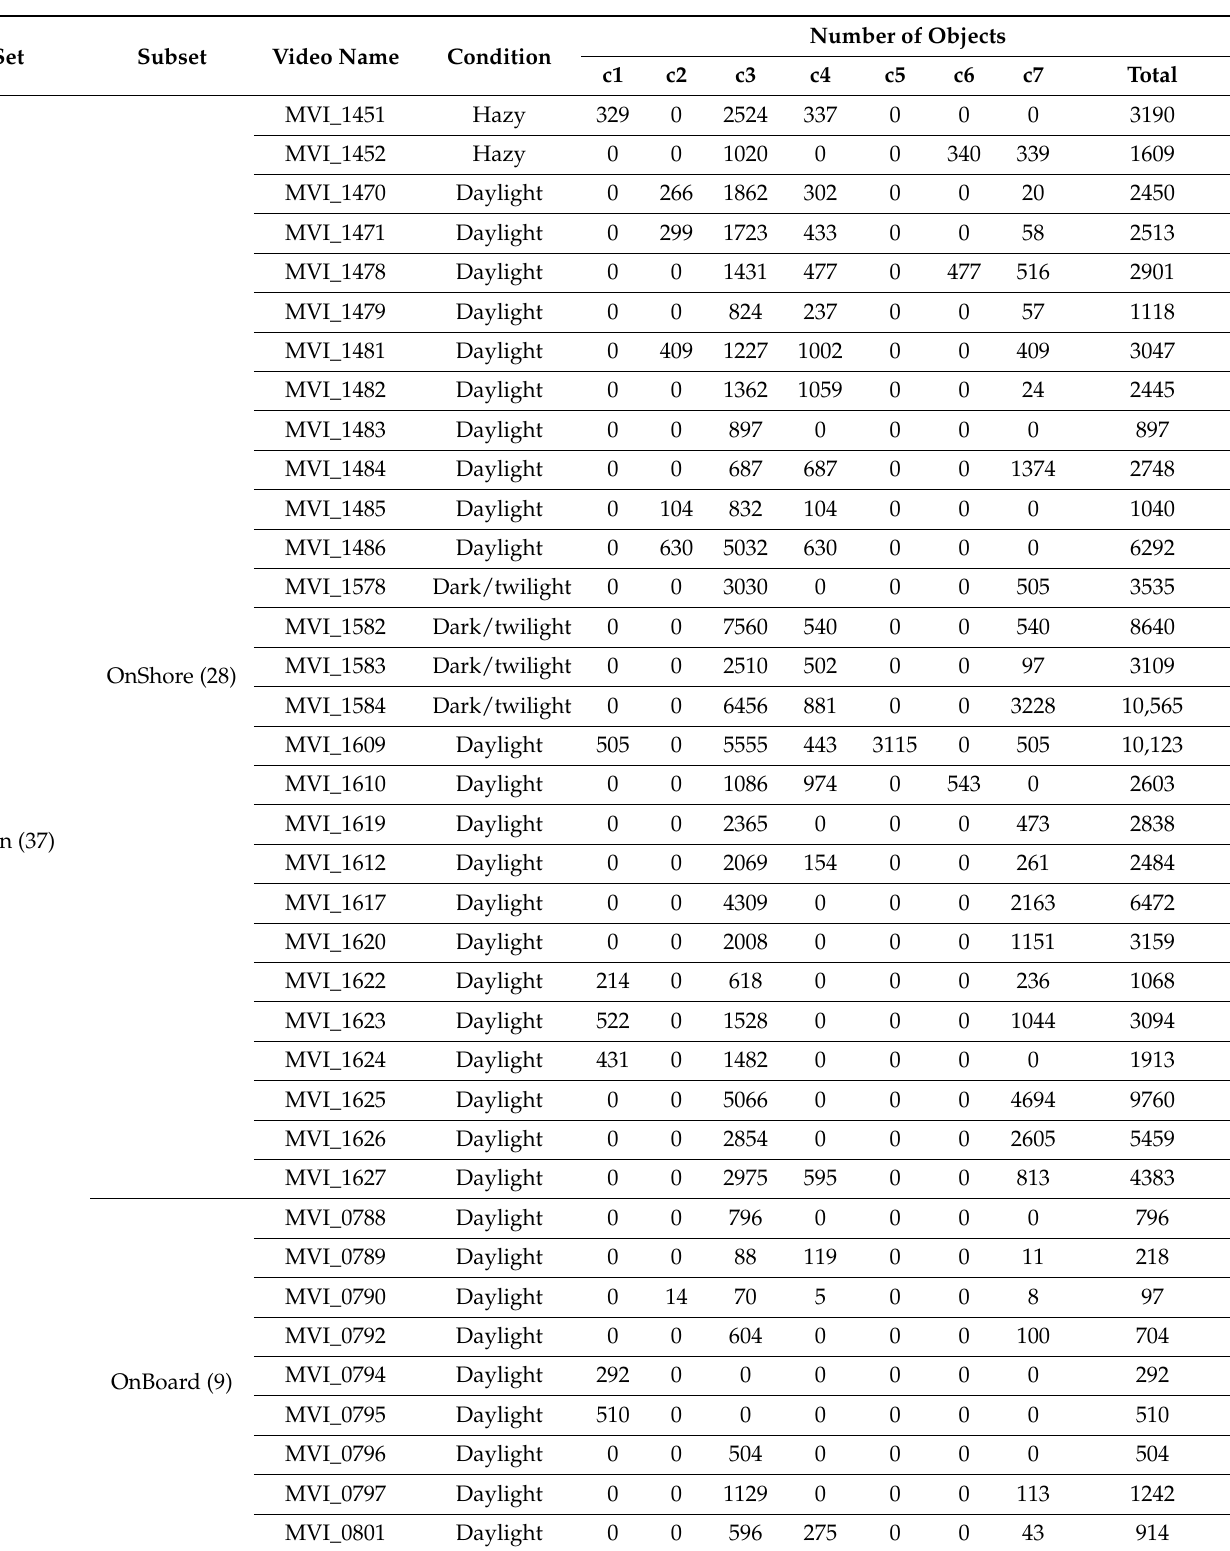
Table 2. Proposed train and test split for VIS video in the SMD (c1: Ferry, c2: Buoy, c3: Vessel_ship, c4: Boat, c5: Kayak, c6: Sail_boat, c7: